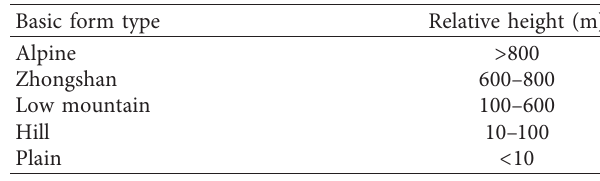
Table 1: Basic morphological indicators of the plain